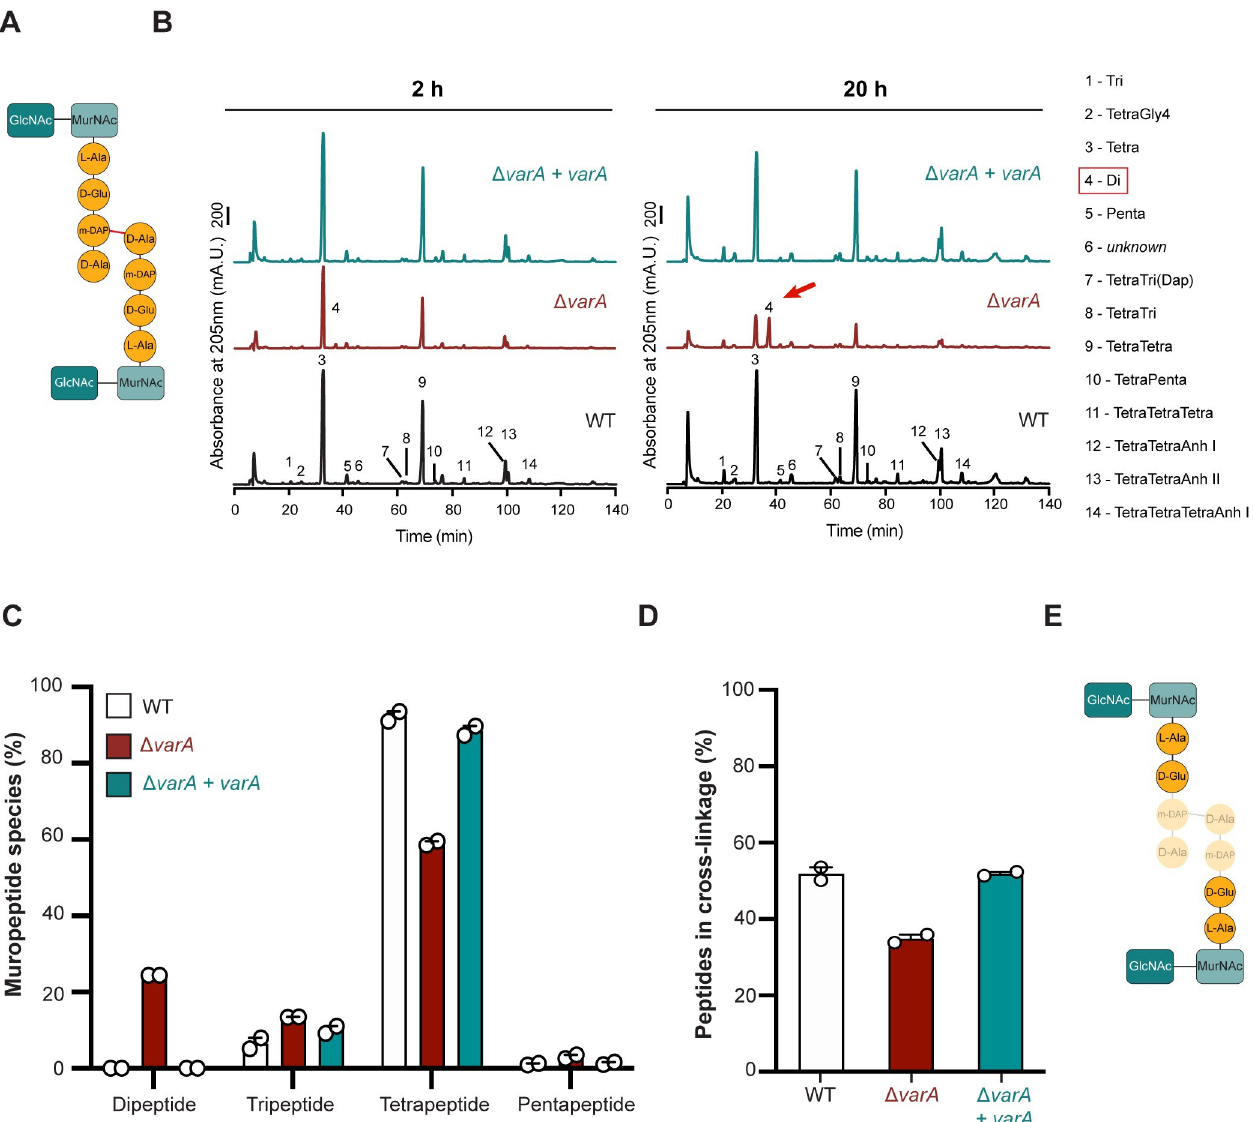
Fig 2. The Δ varA mutant has an unusual PG composition. (A) Scheme of the peptide cross-link in PG. GlcNAc–N-acetylglucosamine; MurNAc–N- acetylmuramic acid; L-Ala–L-alanine; D-Glu–D-glutamic acid; m-DAP–meso-diaminopimelic acid; D-Ala–D-alanine. (B) The Δ varA strain contains a new muropeptide and less peptide cross-links. High performance liquid chromatograms of purified PG from the WT, Δ varA , and complemented Δ varA + varA strains isolated after 2 h or 20 h of growth, followed by digest with cellosyl. Numbered peaks correspond to each muropeptide indicated on the right. (C) The Δ varA strain contains dipeptides in the PG. Quantification of the different peptides in the purified PG of the WT, Δ varA , and complemented Δ varA + varA strains isolated at 20 h post-dilution. (D) The Δ varA strain has less peptide cross-links. Percentage of cross-linked peptides in purified PG derived from the WT, Δ varA , and Δ varA + varA strains after 20 h of growth. For (C) and (D): Values are mean ( ± variance of two biological replicates). See S1 Table for details. (E) Scheme illustrating that dipeptides replace peptide cross-links in the PG of the Δ varA